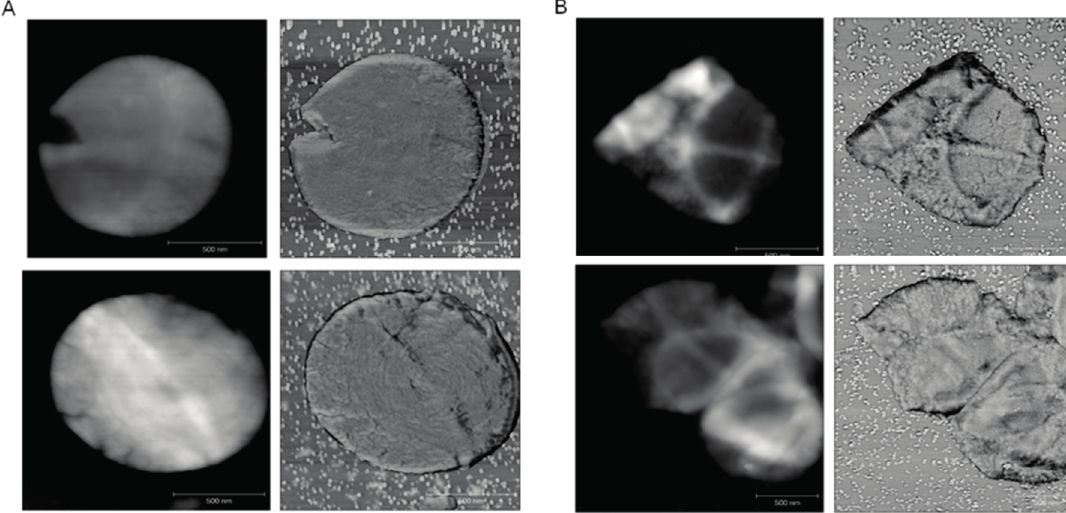
Figure 6. AFM images of sacculi prepared from EMRSA-16 grown in the absence ( A ) and presence ( B ) of 12.5 µg/mL ECg. AFM height ( left panel) and phase ( right panel) images are shown. Scale bars 500 nm. All images show “piecrusts”, thickened bands